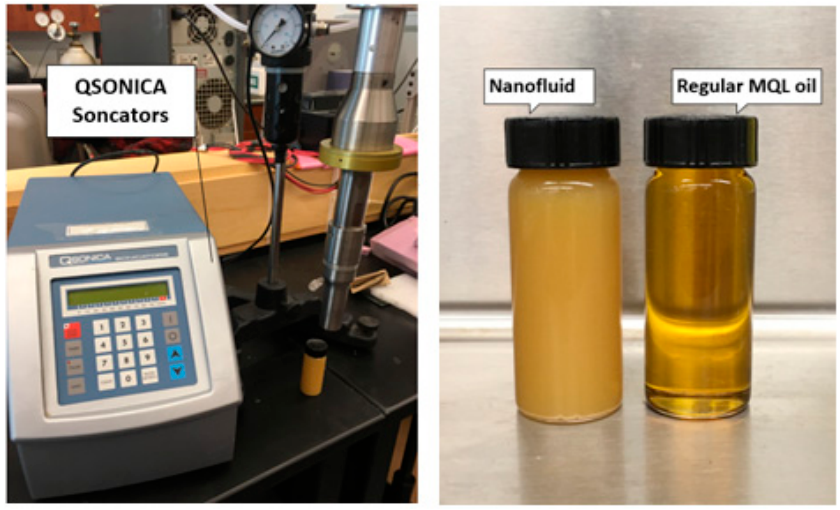
Figure 2. Images of ( left side ) an AQUASONIC-50HT device used to achieve the dispersion; and ( right side ) a classical minimum quantity lubrication (MQL) and MQL-nanofluid (Al 2 O 3 -based). Table 1. L9 Taguchi method (L9OA) for design of experiments. Experiment